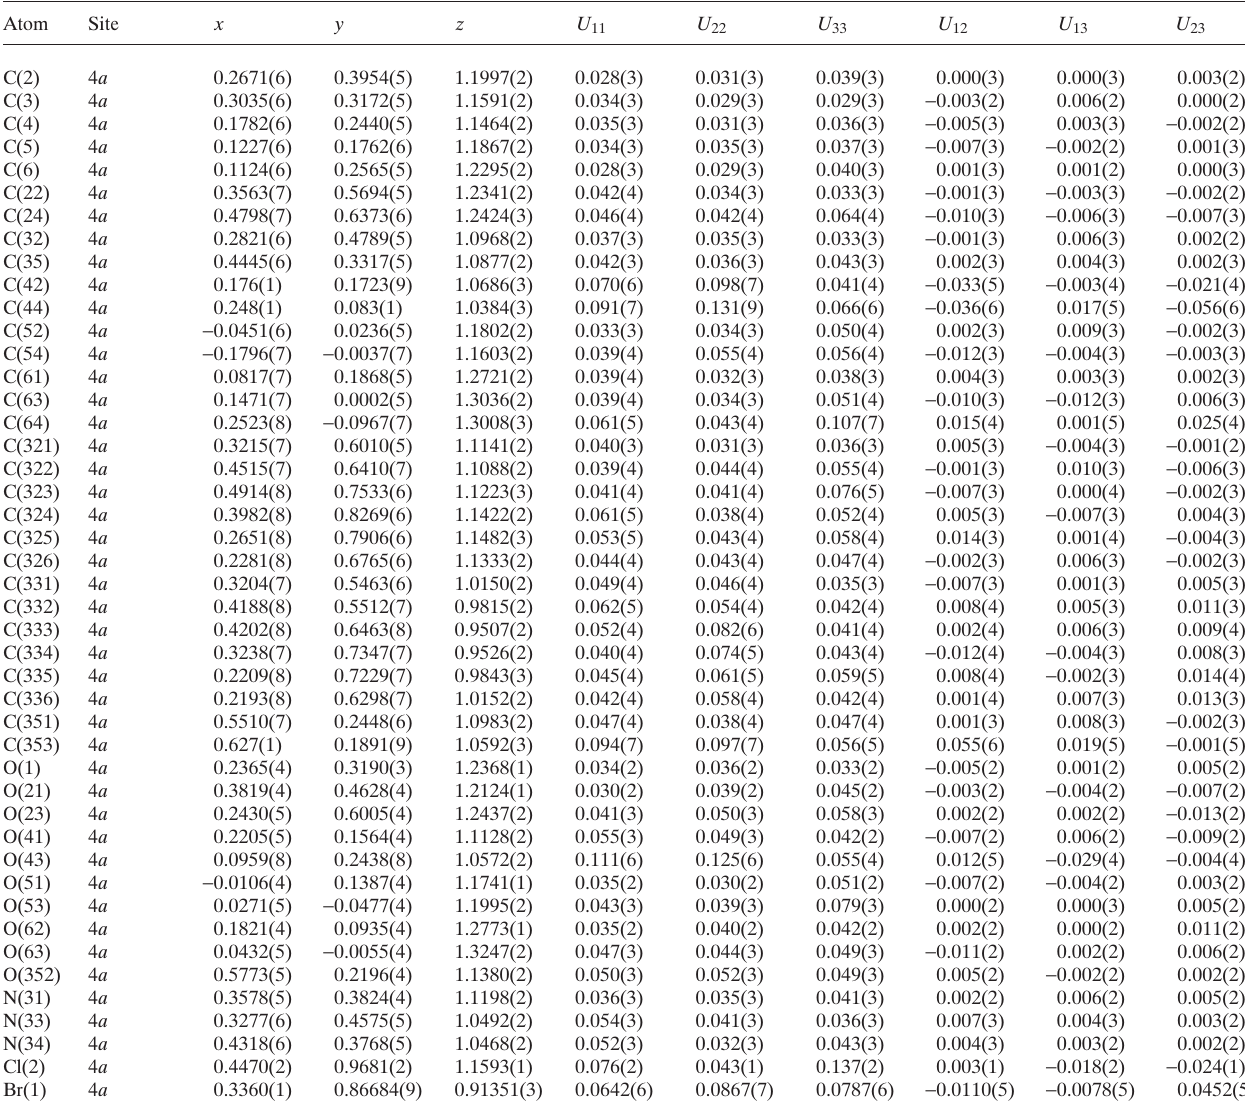
Table 3. Atomic coordinates and displacement parameters (in Å 2 )